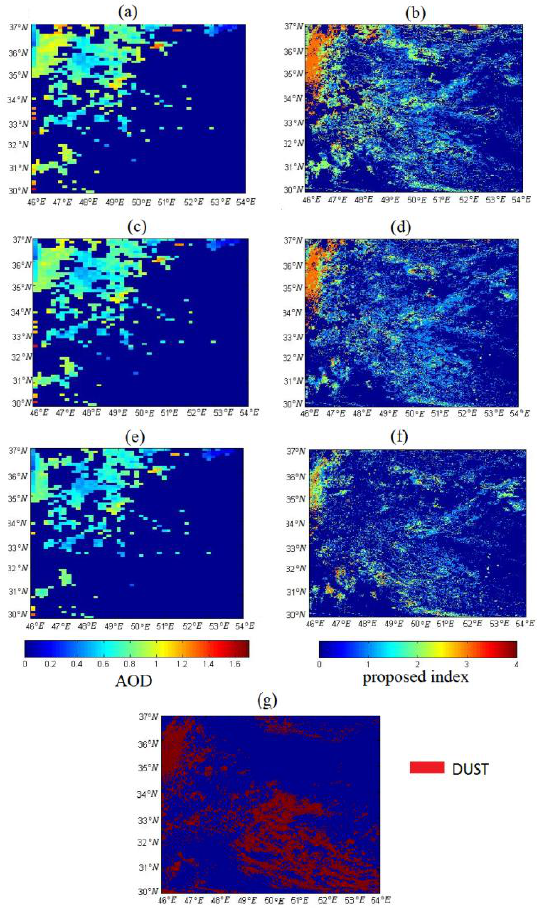
Figure 3. comparing our algorithm result and MOD04 and BTD of dust phenomena in 15 may of 2005. (a) MOD04 AOD 0.47 μm, (b) our proposed index for 0.47 μm, (c) MOD04 AOD 0.55 μm, (d) our proposed index for 0.55 μm, (e) MOD04 AOD 0.66 μm, (f) our proposed index for 0.66 μm, (g) BTD